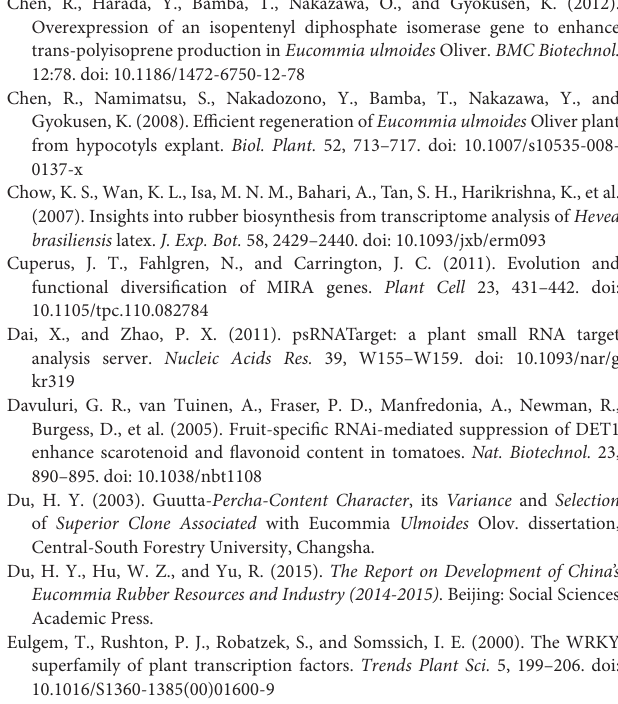
in the color key. Table S5 | Predicted novel miRNAs and their pre-miRNA sequences in Eucommia ulmoides. Expression profiles of conserved miRNAs were estimated